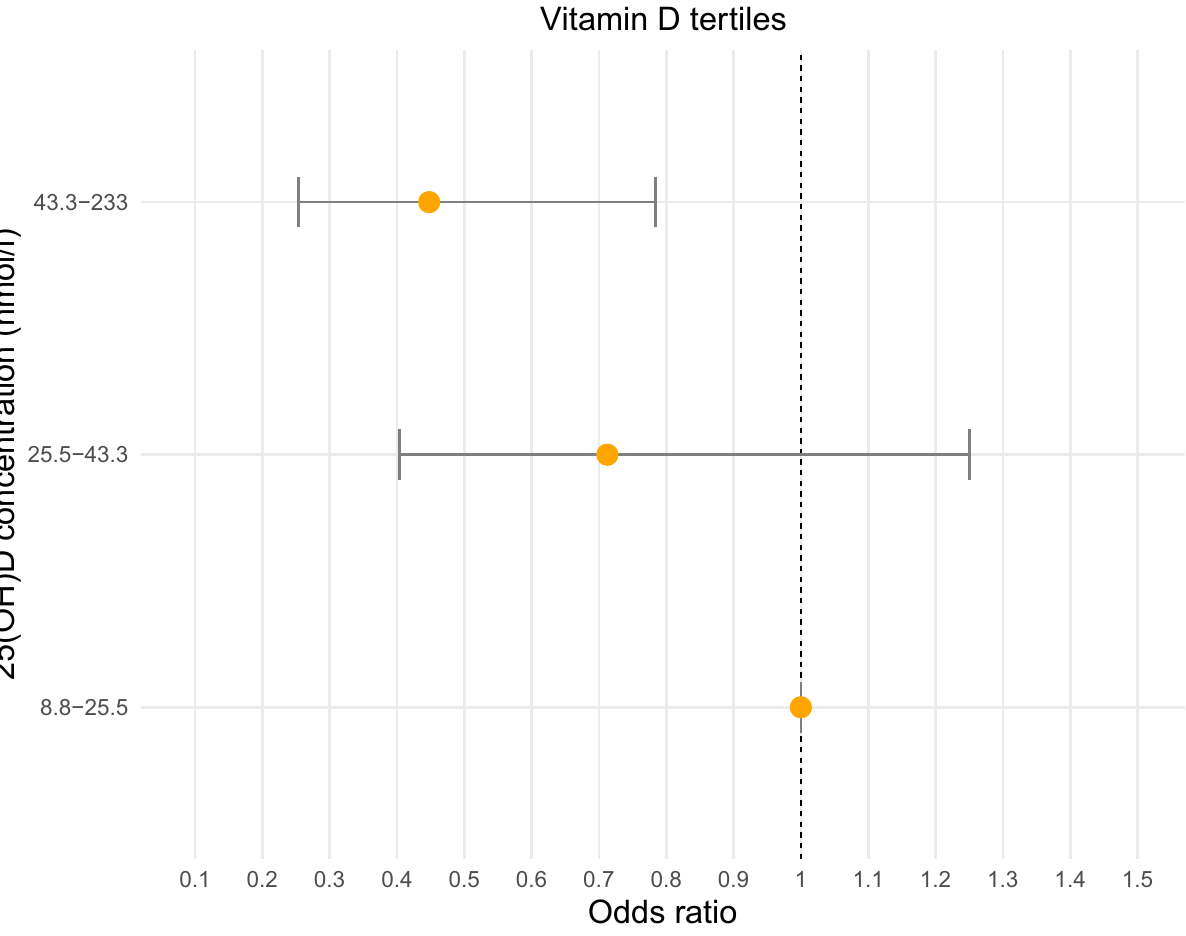
Fig 2. Raw odds ratios (95% CI) of each tertile of 25(OH)D for in-hospital morbidity/mortality. Figure shows the odds ratio (yellow dots) and confidence interval (horizontal lines) for in-hospital outcomes for each tertile, using the first tertile as a reference. The odds versus patients with vitamin D < 25 nmol/L (reference category) were significantly lower in patients with vitamin D > 43.3 nmol/L, while the odds did not differ significantly in patients with vitamin D 25(OH)D in the range 25.5–43.3